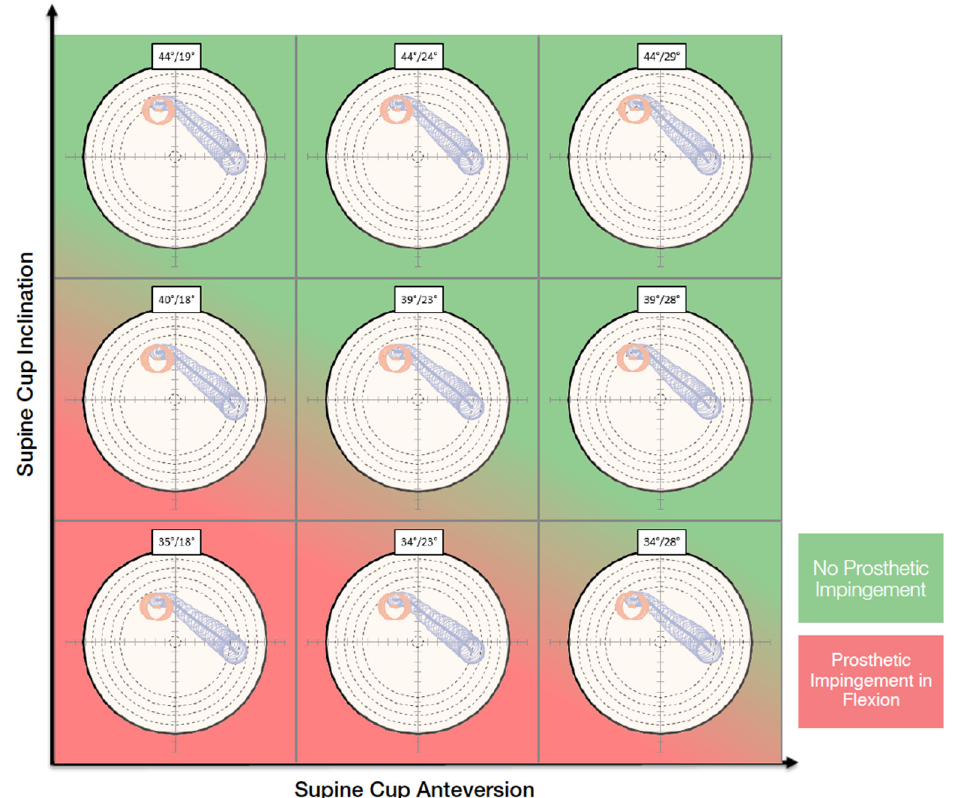
Figure 1. Nine different cup orientations are provided to the surgeon with an indication of the risk of